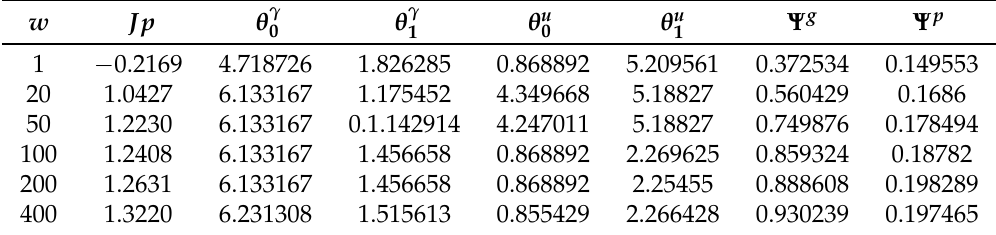
Table 6. Search evolution of